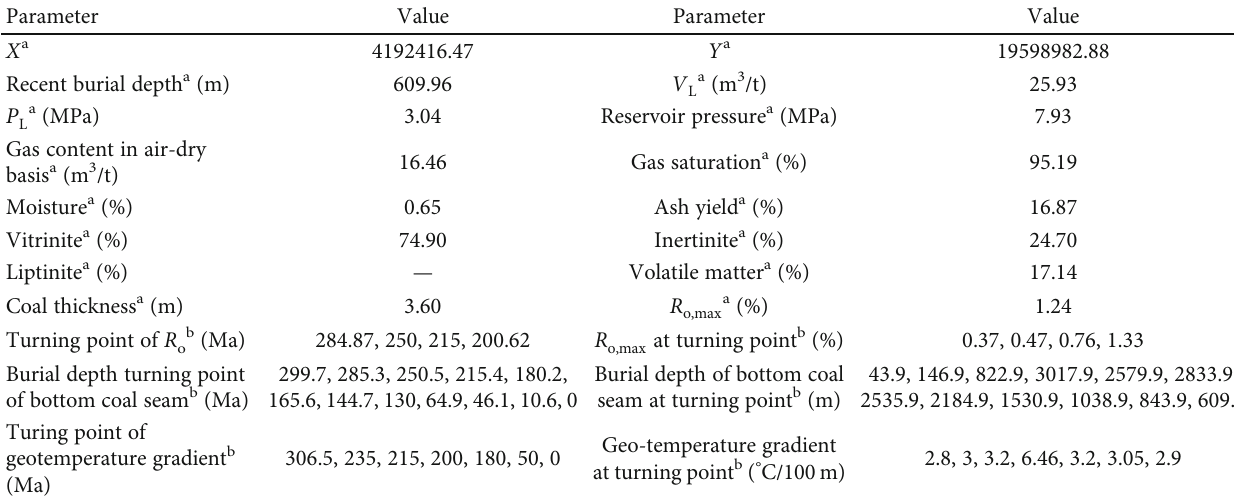
Table 1: The database of simulation nodes that contain well